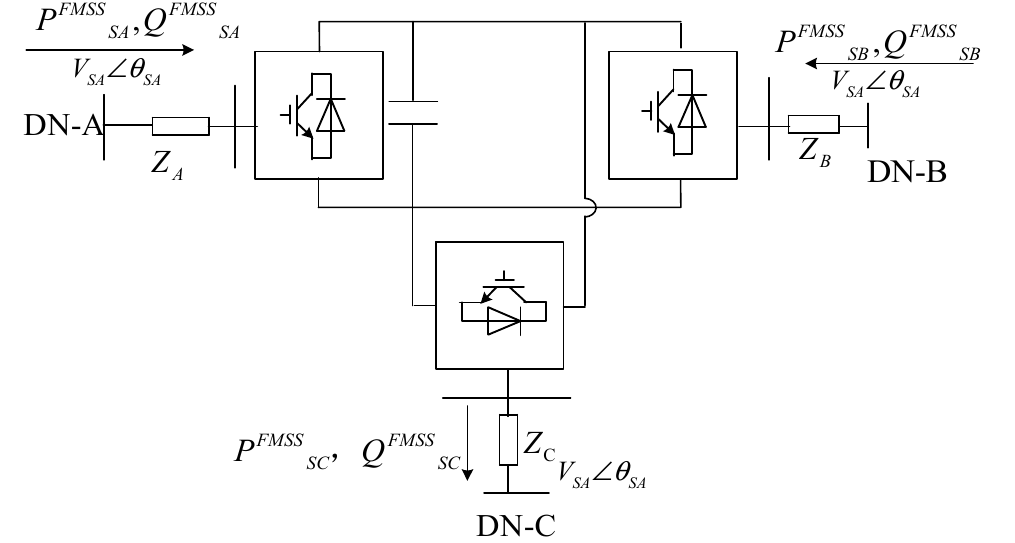
Figure 3. The topology of the three-terminal flexible multi-state switch.